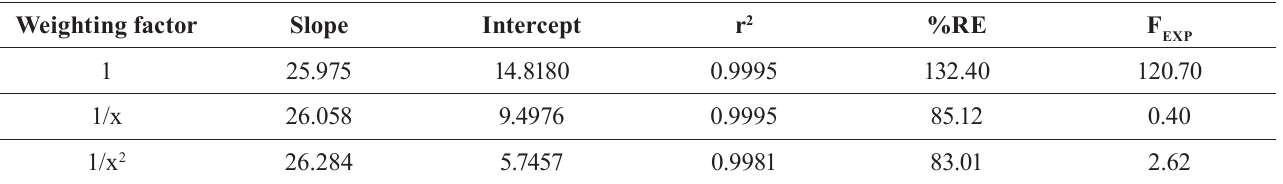
TABLE I - P arameters for weighted and unweighted regression models for linearity Weighting